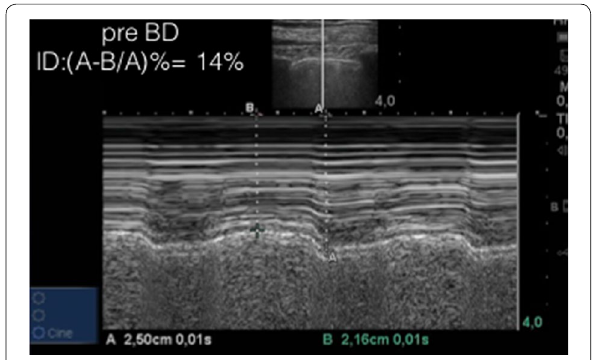
Fig. 1 M-mode evaluation of pleural vertical displacement and calculus of the comparison index: Skin-to-maximalinspirationpointdistance ( A ) − skin-to-maximalexpirationpointdistance ( B ) skin-to-maximalinspirationpointdistance ( A ) × 100